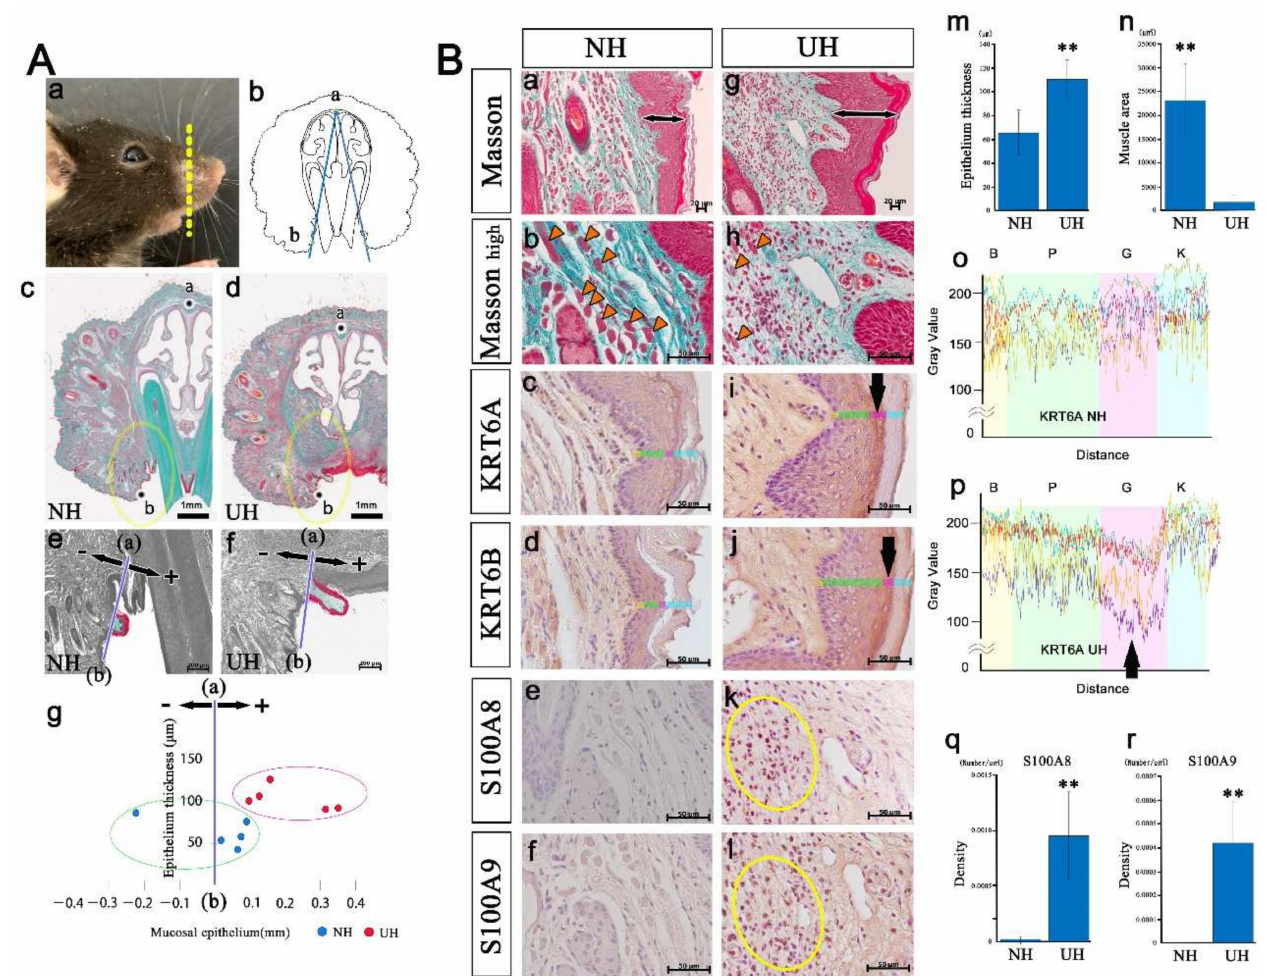
Figure 5. An upper lip comparison between the non-extraction control (NH) and tooth loss (UH) groups: ( A ) Histological studies of upper lips. The upper lip was more strongly protruded into the oral cavity in UH mice than in NH mice (Panels c–g). ( B ) High-magnification views of the upper lips. After extracting an incisor, the thickness of the upper lip’s epithelium was increased (Panels a and g) (Panel m; ** p < 0.01). The cross-sectional area of the orbicularis oris muscle (arrowheads) was reduced (Panels b and h) (Panel n; ** p < 0.01). KRT6A/6B fluorescence intensity in the granular layer was lower in UH mice than in NH mice (Panels c, d, i, j, o, and p). S100A8/A9 density was significantly higher in UH mice than in NH mice (Panels e, f, k, and l) (Panels q and r; ** p <